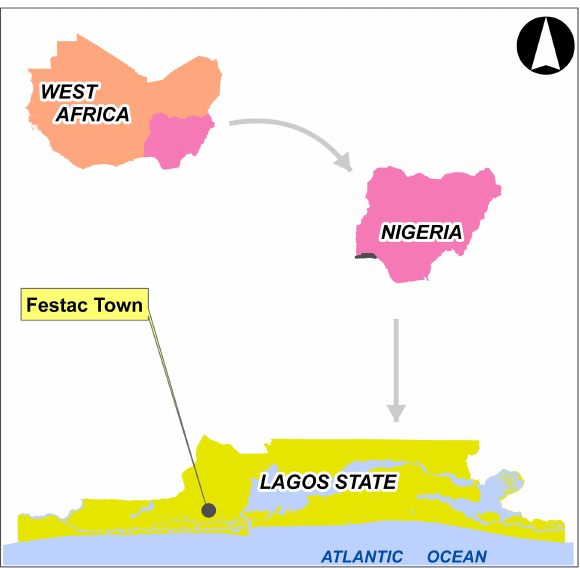
Figure 1: Map showing the location of the study